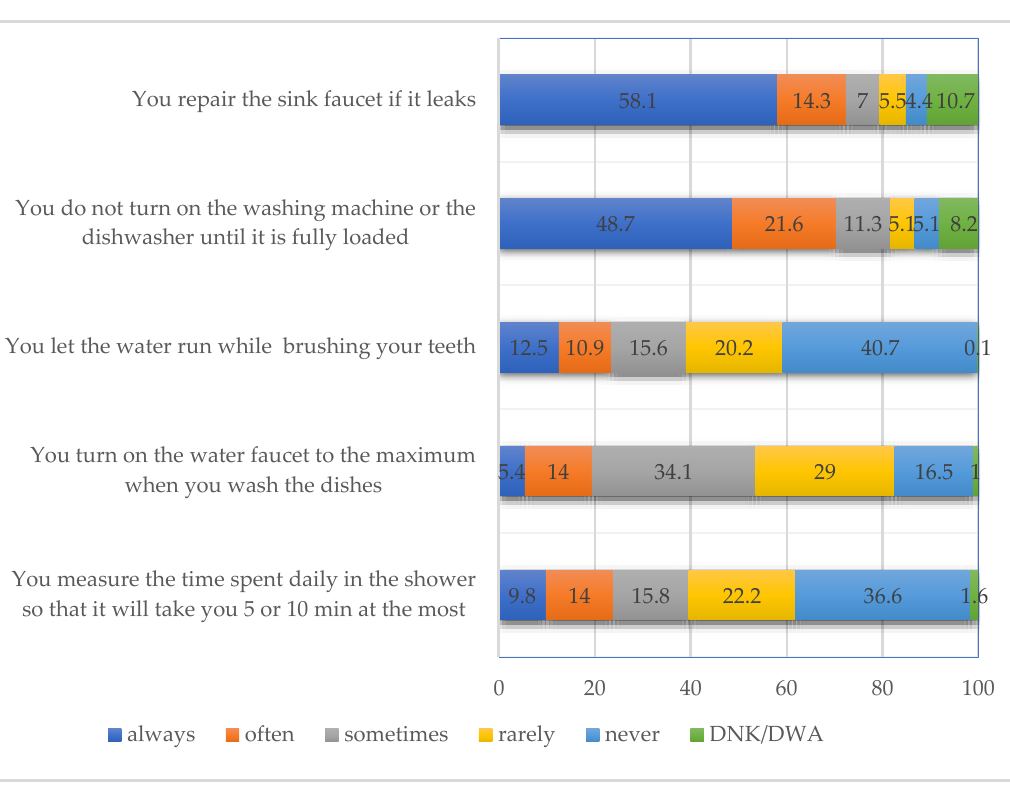
Figure 3. Respondents’ behavior towards water consumption in the household. The same situation is recorded for “You turn on the water faucet to the maximum when you wash the dishes” where 45.6% of the responses suggest the absence of such a behavior. Still, in this case, this statement has recorded the highest percentage of